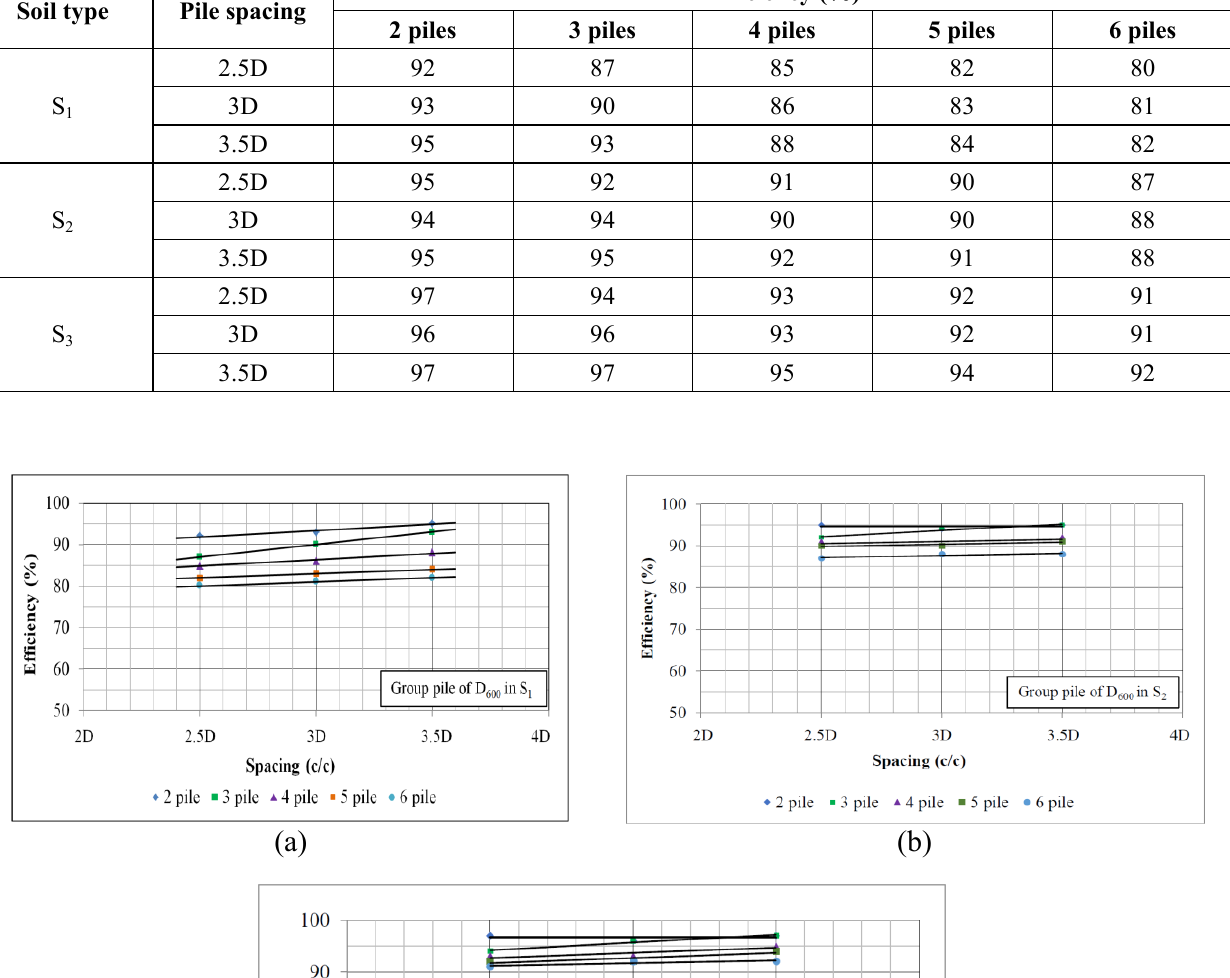
(b) soil S and (c) soil S 1 2 3